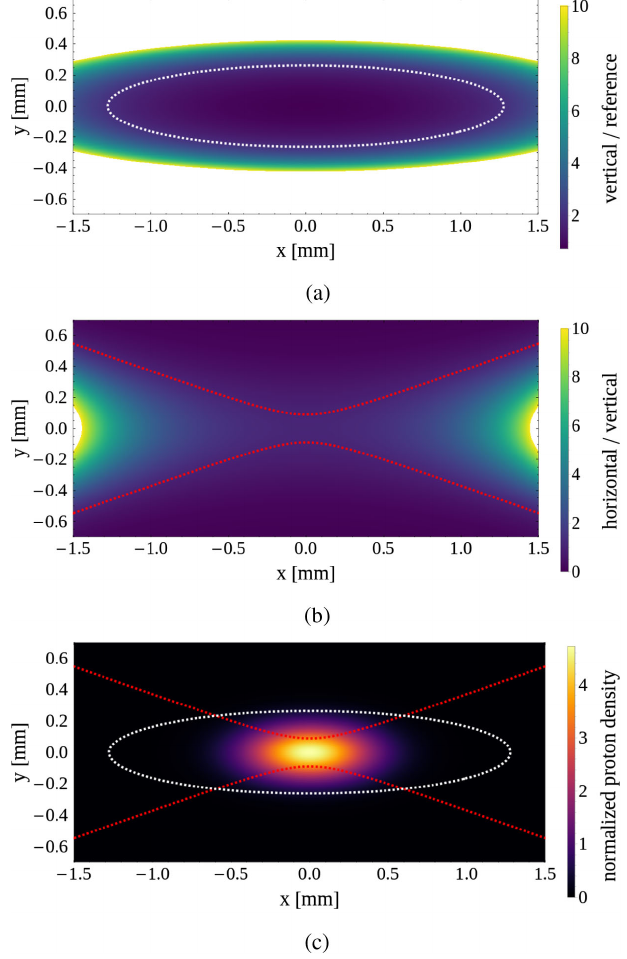
FIG. 7. (a) vertically blown-up bunch distribution divided by that of the reference bunches, (b) horizontally blown-up bunch distribution divided by that of the vertically blown-up bunch, (c) reference bunch distribution. The contour line in (a) corre- sponds to a factor of 2, whereas the contour lines in (b) corre- sponds to a factor of 1. These contour lines are overlayed on the reference bunch distribution in